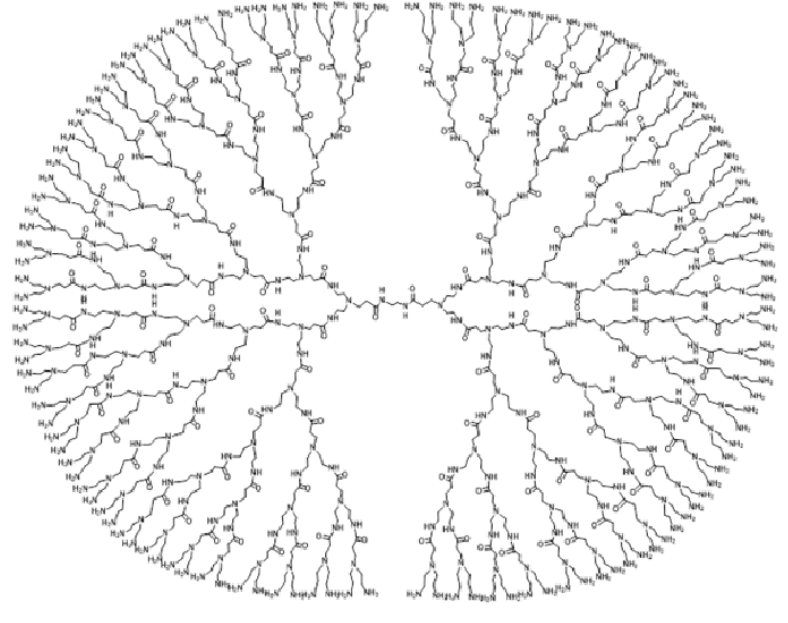
Figure 2. Chemical structure of Poly(EThyleneAmidoAmine) (PETAA) dendrimer D ( 5 )